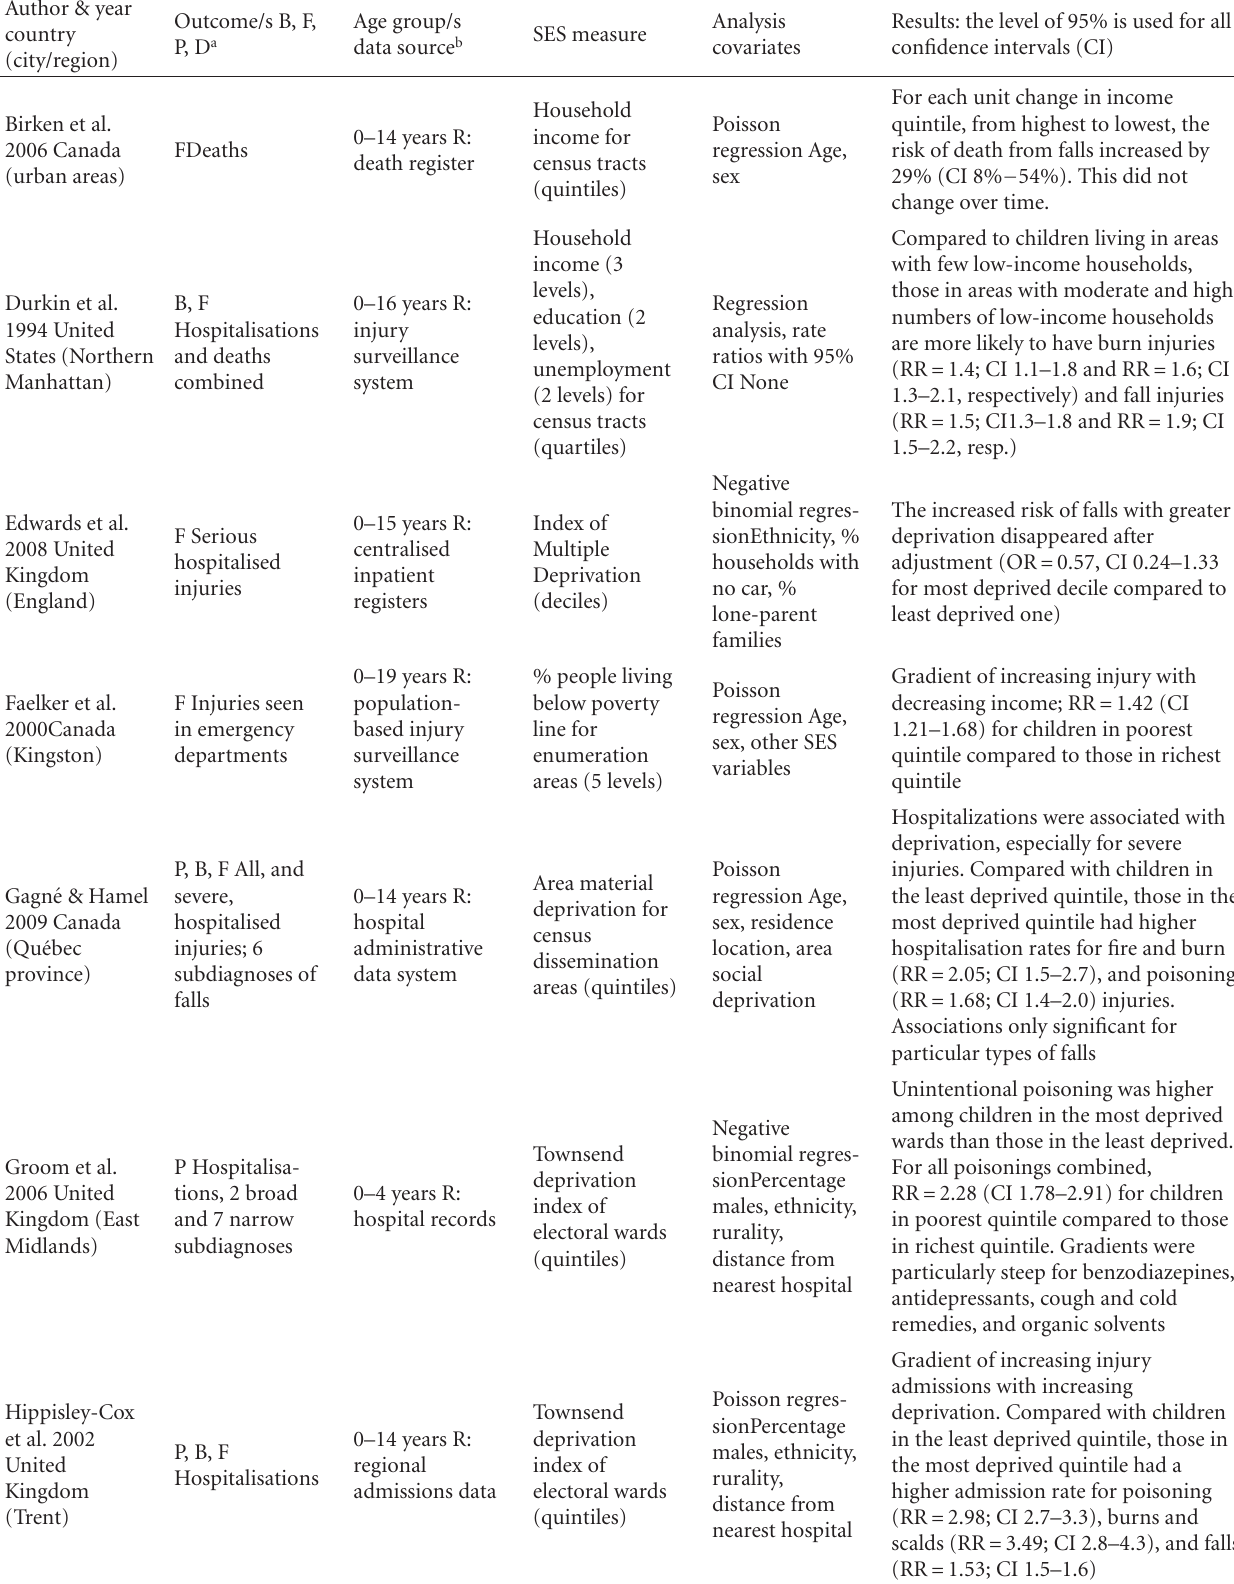
Table 6: Area-level studies for childhood burn, fall, poisoning, and drowning injuries: summary of methodological features and results ( n =